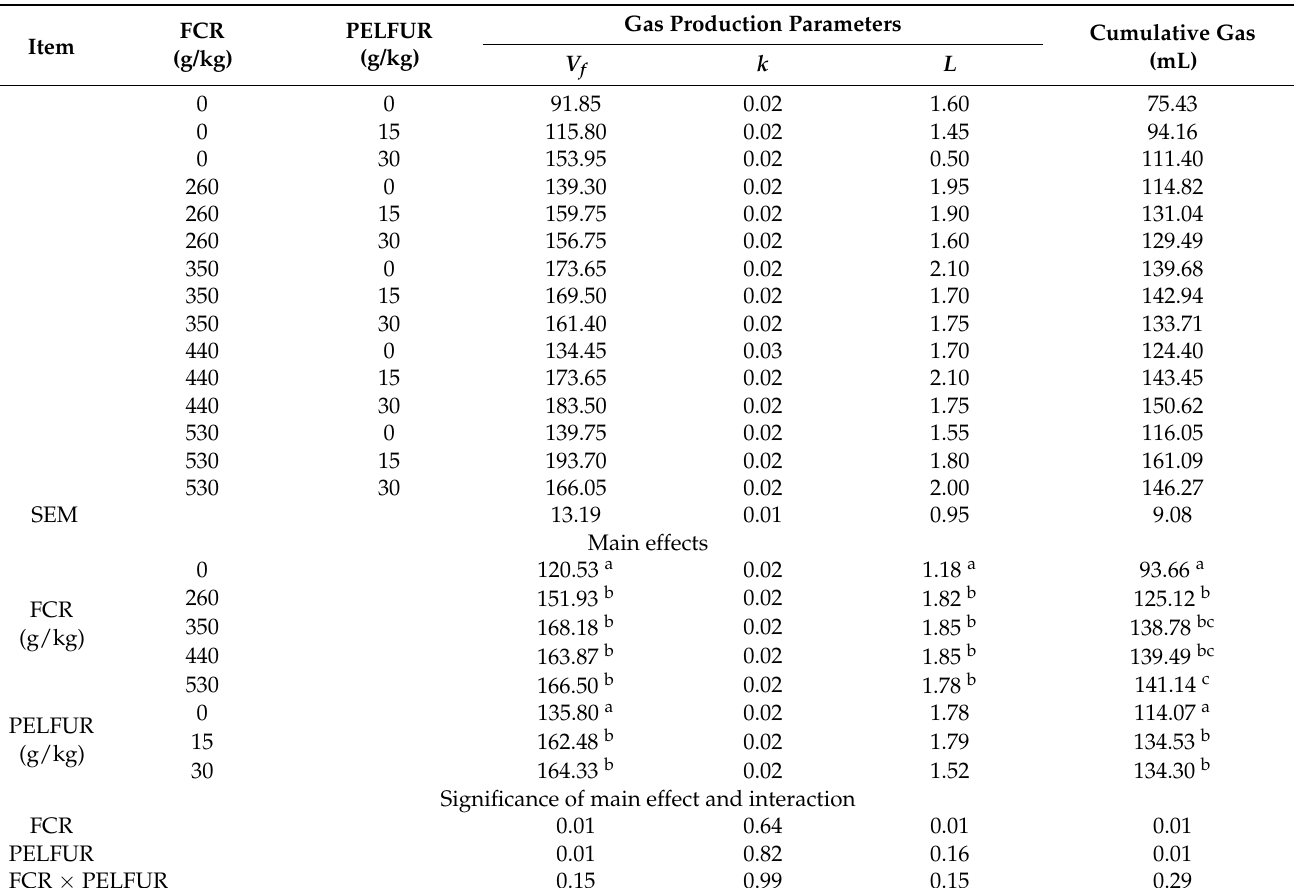
Table 2. Effect of fresh cassava root (FCR) with pellets containing high sulfur (PELFUR) on gas production parameters and cumulative gas at 96 h after